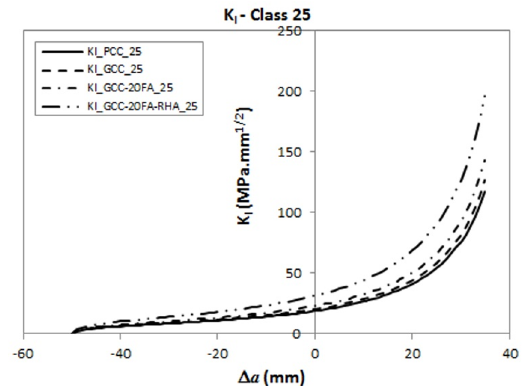
) with the nominal I